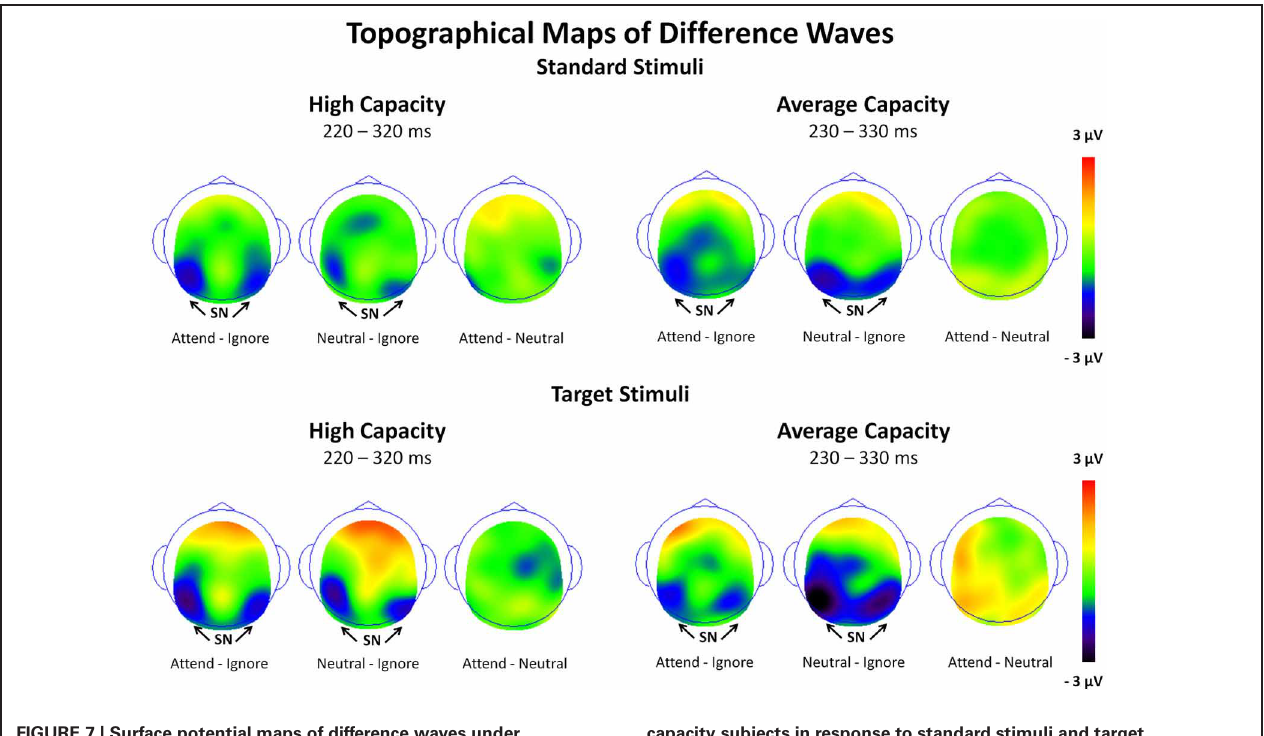
FIGURE 7 | Surface potential maps of difference waves under Attend—Ignore, Neutral—Ignore, and Attend—Neutral conditions for the SN interval for high capacity and average